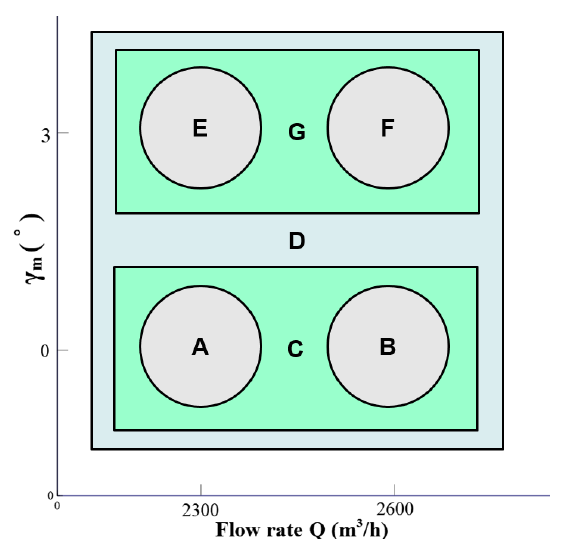
Figure 6. Metamodeling